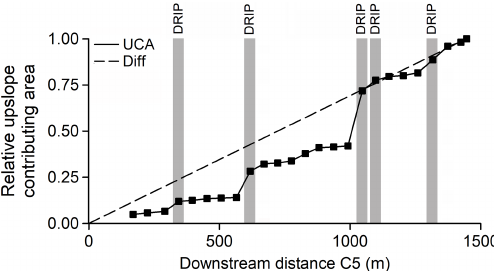
Figure 3. Relative upslope contributing area along the stream reach. The solid line represents the UCA model, which assumes that the net gain in streamflow is proportional to the gain in UCA between sampling sites (squares). The dashed line represents the “Diff” model, which assumes uniform, diffuse inflow of groundwa- ter along the entire reach. Grey vertical bars indicate the locations of discrete riparian inflow points (DRIPs) along the stream reach, for which we sampled dissolved organic carbon (DOC) concentrations during the study period and in-stream DOC uptake was